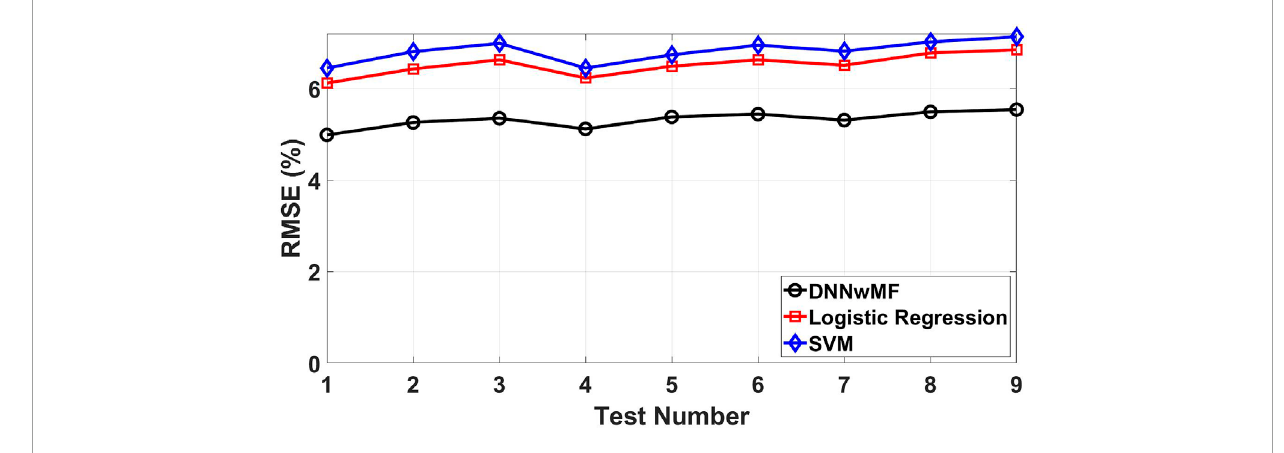
FIGURE 8 RMSE (%) vs. test number of UMD CALCE